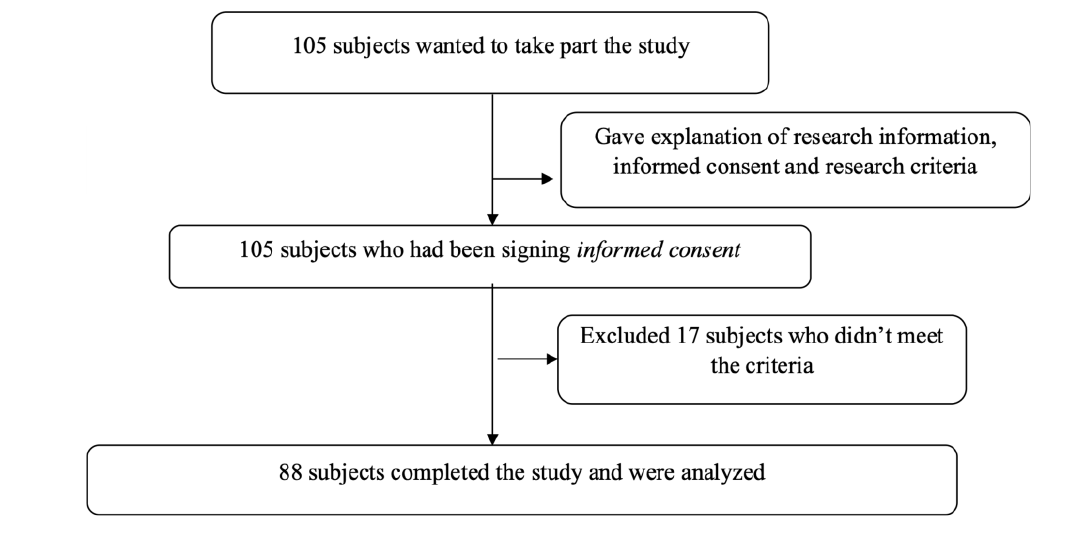
Figure 1. Subjects selection